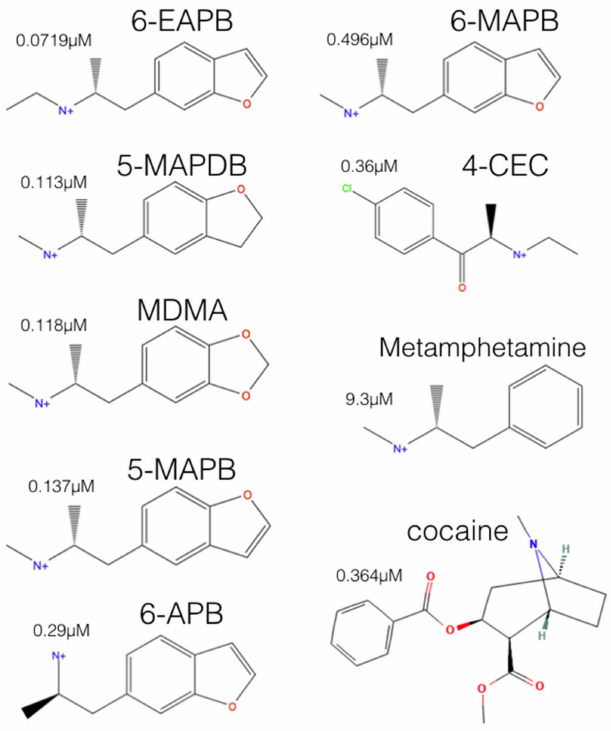
Figure 2. Selected hSERT blockers to simulate the ligand-protein interaction of S1 and S2 of the hSERT associated to their [ 3 H]5-HT uptake inhibitory potencies (IC 50 s) from functional reuptake assays of HEK-293 cells stably expressing the hSERT. Experimental values taken from